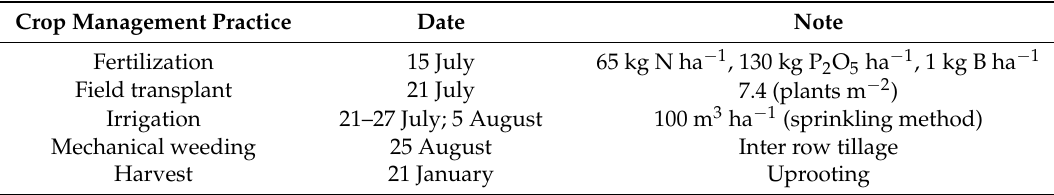
Table 4. Crop management practices during the experimental year